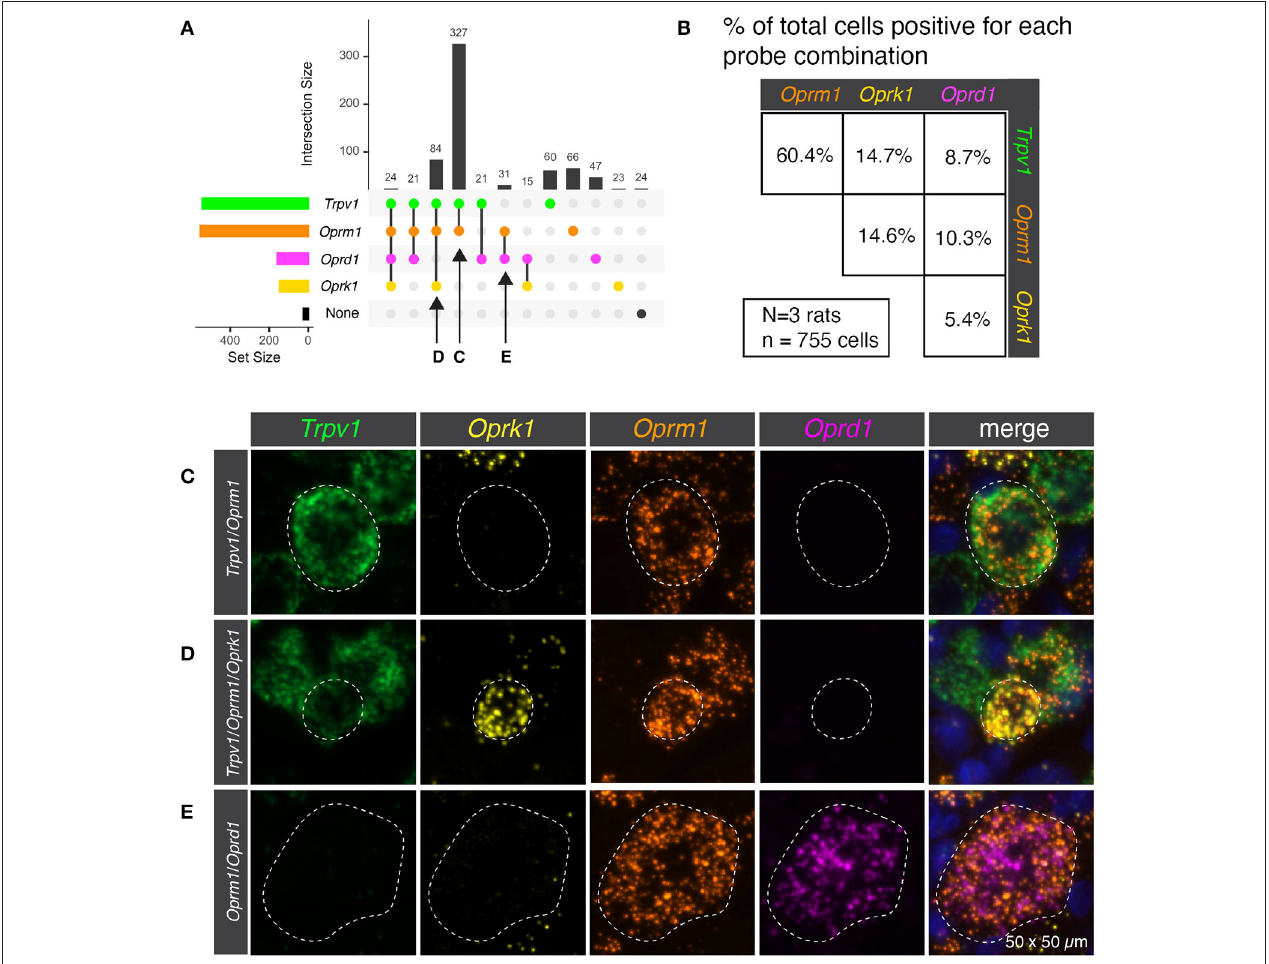
FIGURE 1 | Co-expression of transient receptor potential vanilloid 1 ( Trpv1 ) and the three opioid receptors ( Oprm1 , Oprk1 , Oprd1 ). (A) Semiquantitative analysis was performed to count the number of cells present or absent for each of the four marker genes. This analysis subdivided the sensory afferents into 12 populations, although not all of these populations were prevalent. (B) In order to simplify the overlap between Trpv1 and Opioid receptor transcripts, a pairwise matrix of percentages is shown. This shows the total number of neurons positive for each marker (set size) as well as the number of cells positive for combinations of markers (intersection size; see Methods section). This display clarifies that Trpv1 / Oprm1 cells were very prevalent in the DRG, comprising 60.4% of all neurons (ignoring + + categorization by the other markers.). While all possible combinations were identified, some were quite rare, with the population of cells positive for both Oprk1 and Oprd1 (the rarest combination) comprising 5% of neurons. (C) Representative multi-channel microscopy images are shown for three of the populations identified in ∼ /Oprm1 panel A, the first of which being Trpv1 neurons. These neurons were the most abundant population at 327 of 755 total cells (or 43.3%). (D) The + + Trpv1 /Oprm1 / Oprk1 population is shown, which is the second most abundant subpopulation at 84/755 cells (11.1%). (E) Finally, a representative cell from the + + + Oprm1 /Oprd1 population is shown. This population is rare, but is large and expresses very high levels of both Oprm1 and Oprd1 . Outlines of neurons are shown + + to enhance visibility (dotted lines).